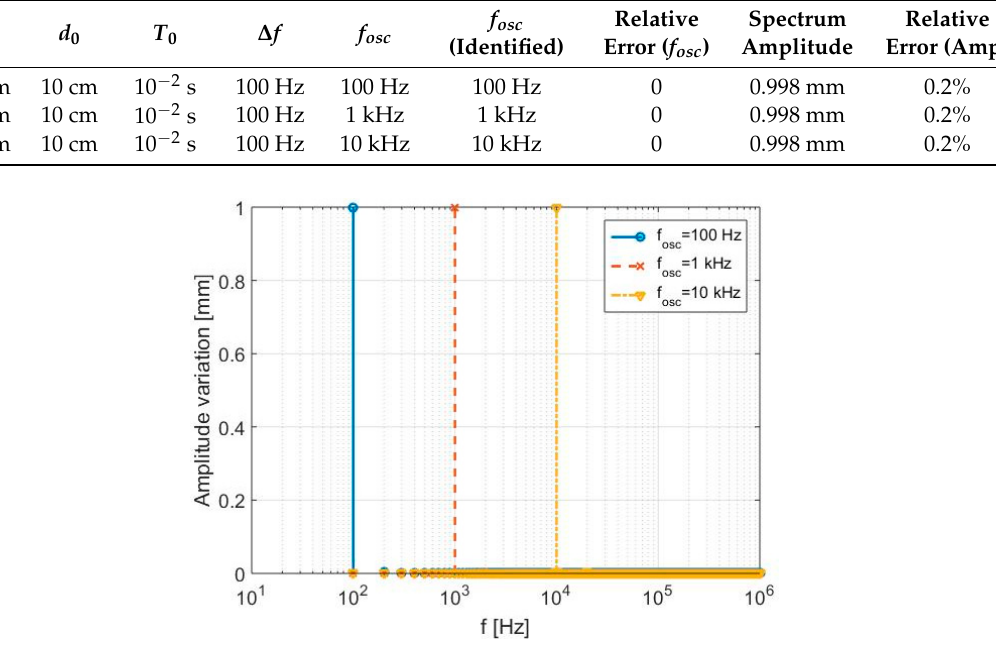
Figure 4. First simulation—Detected displacement spectra.